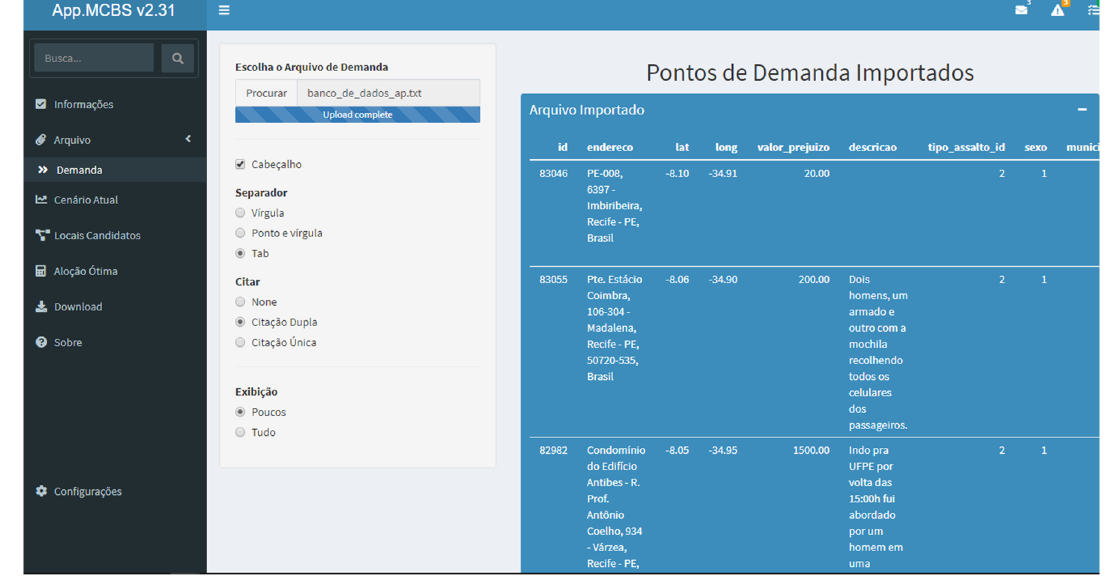
Figure 3. File screen of proposed MIS.